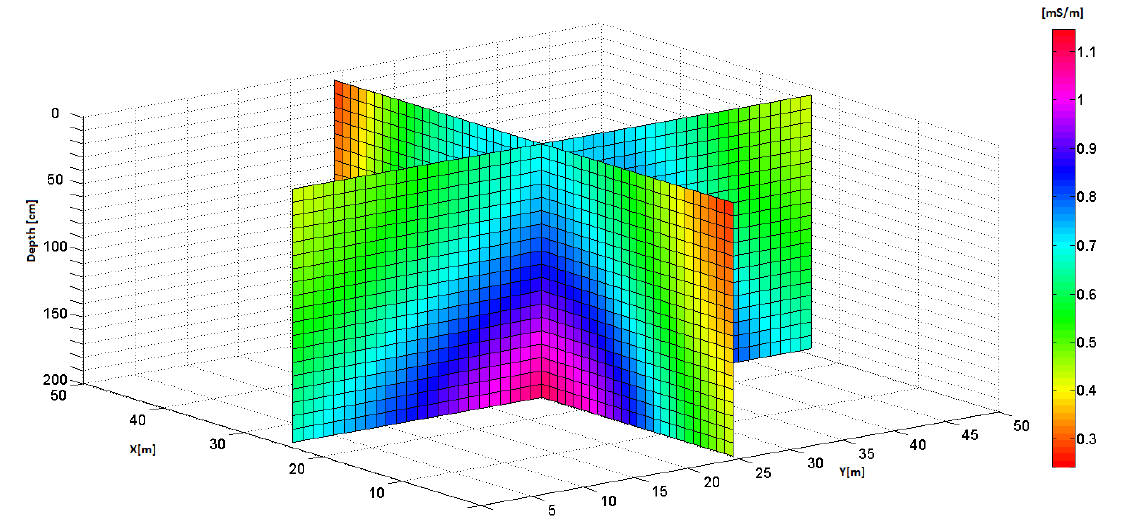
Figure 12. Electrical conductivity section in silt soil